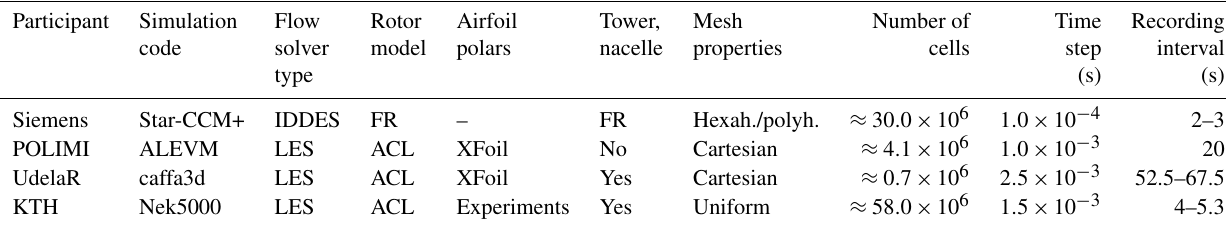
Table 2. Overview of simulation methods and parameters. Abbreviations: improved delayed detached eddy simulation (IDDES), large eddy simulation (LES), actuator line (ACL), and fully resolved